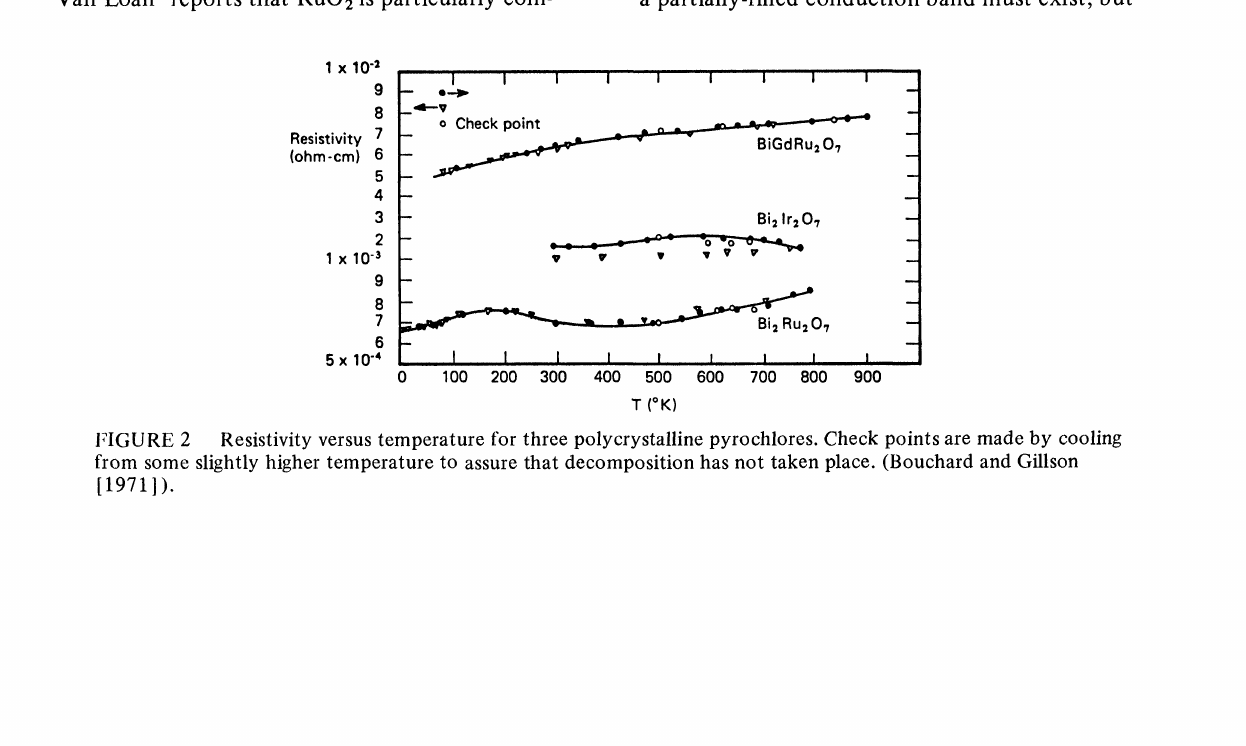
FIGURE Electrical properties of ruthenium dioxide glaze resistors (Angus and Gainsbury 19681 ). 20 wt% Nb2Os calcined with the dioxide to control the TCR. RuO2 forms a solid solution with Nb2Os and, on adding 20% Nb20s, the RuO2 lattice a parameter changes from 4.49 A to 4.57 A and the c parameter from 3.11 )k to 3.07 A. A 3.2 mole% of Nb2Os in RuO2 gives the alloy an effectively zero TCR over a wide range of resistor compositions, lies states that up to 60 wt% Ag can be used in place of RuO2 in resistor compositions without affecting the TCRs adversely. Zn and Cd borosilicates are found to be preferable to Pb borosilicates in that they can modify the TCRs of resistor compositions by +250 x 10 -6 K -1, which shows the importance of the glassy phase to the conduction process.